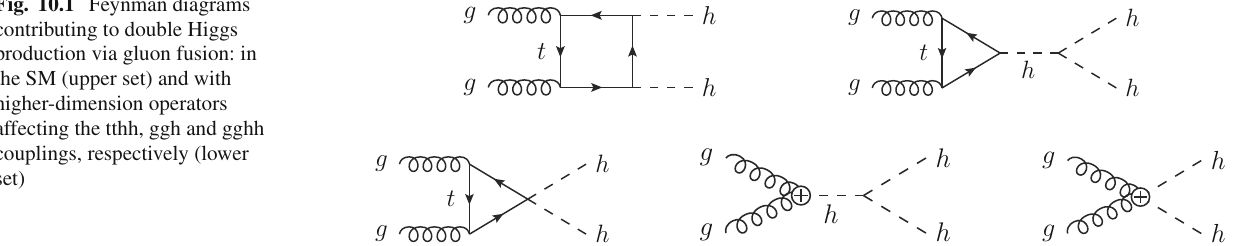
contributing to double Higgs production via gluon fusion: